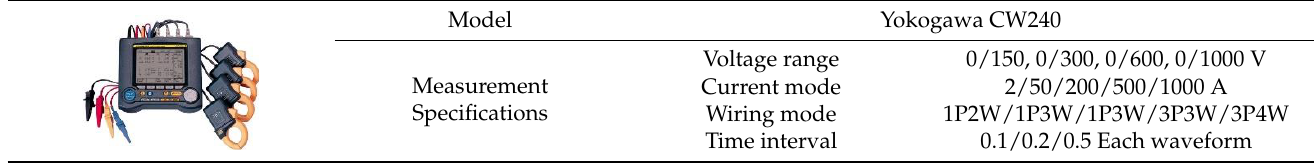
Table 8. Power meter specification.